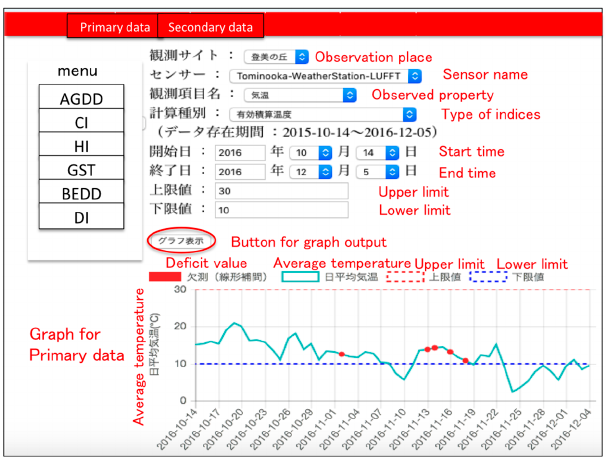
Figure 14. Secondary index displayed in web application. Since this application is written in Japanese, English annotation is mentioned with red letter.